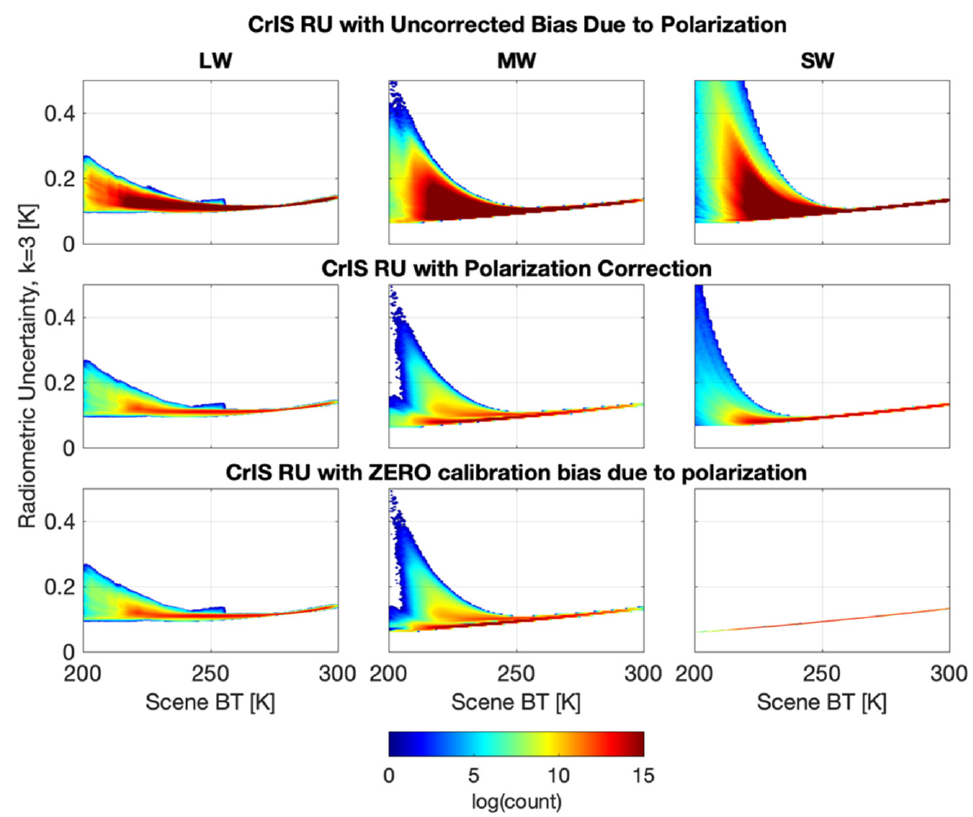
Figure 23. On-orbit 3- σ (k = 3) radiometric uncertainty estimate for one orbit of data from NOAA-20 CrIS, presented in the same format as Figure 22.